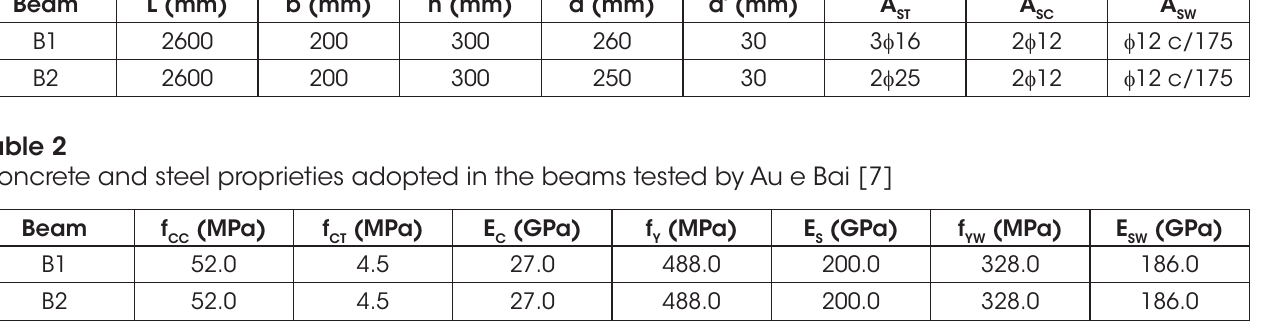
Dimensions and reinforcements for the beams tested by Au and Bai [7] Beam